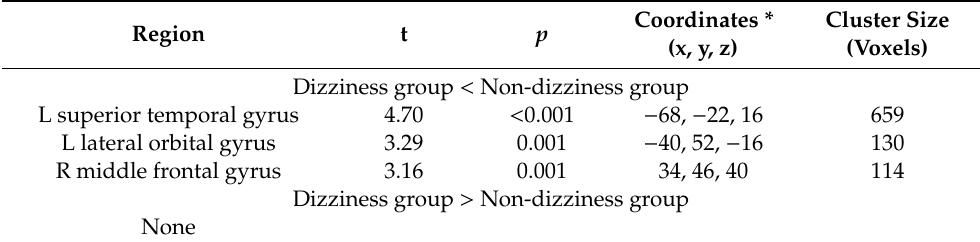
Table 4. Group di ff erences for regional cerebral blood